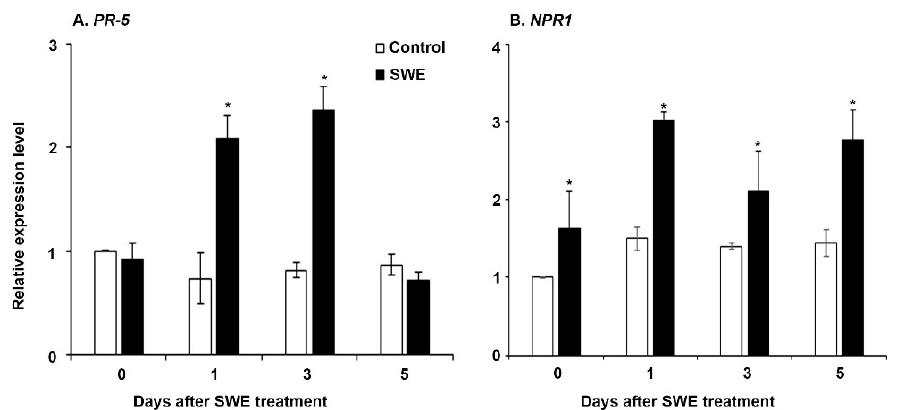
Figure 4. Relative quantification of the expression (fold change) of priming-related genes: ( A ) PR5 and ( B ) NPR1 in S. lycopersicum at 0, 1, 3, and 5 days after a single application of SWE or water as the control. Data shown are the mean of three independent biological replicates (each replicate consisted of 10 plants) and bars represent the standard error of mean. * denotes significant difference ( p = 0.05) between SWE and control samples at each time point according to Duncan’s multiple range